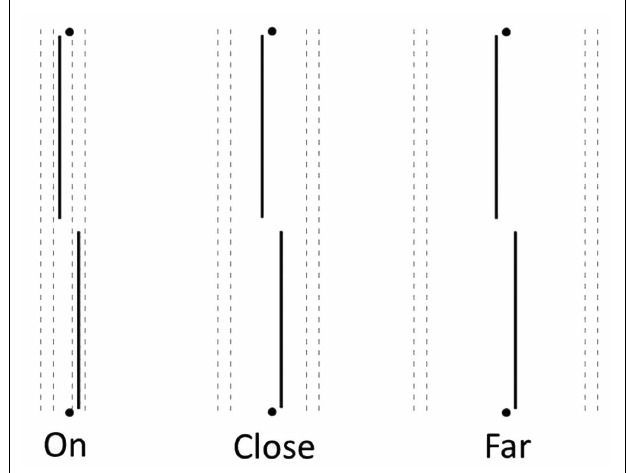
FIGURE 1 |Two-line acuity targets surrounded by imaginary lines, ON, CLOSE, or FAR away, as directed by small guide spots or lines at top and bottom of the fixation field (not shown). Real black or gray lines were positioned in the same places as the imagined ones.